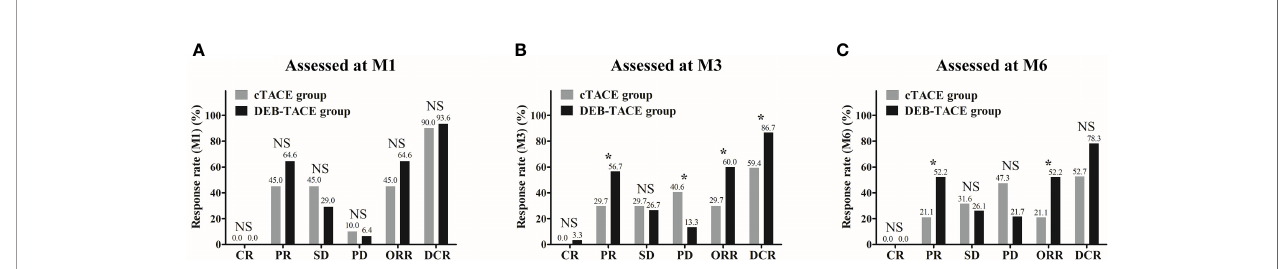
FIGURE 2 | Treatment response rate between the DEB-TACE and cTACE groups. No difference in CR, ORR, or DCR was observed between the DEB-TACE and cTACE groups at M1 (A) . At M3, CR was similar, whereas ORR and DCR were higher in the DEB-TACE group compared with the cTACE group (B) . At M6, ORR was higher while CR and DCR were similar in the DEB-TACE group compared with the cTACE group (C) . Comparisons of response rates between the two groups were performed using Chi-square test, and p < 0.05 was considered signi fi cant. * p < 0.05; NS, not signi fi cant; DEB-TACE, drug-eluting bead transarterial